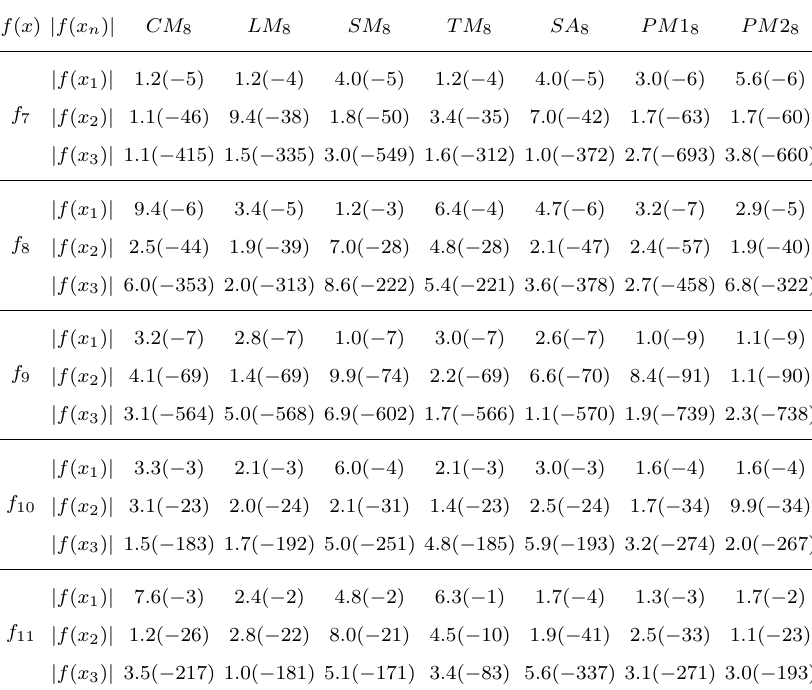
Table 2. Comparison of residual error on the test examples f 7 ( x ) – f 11 ( x